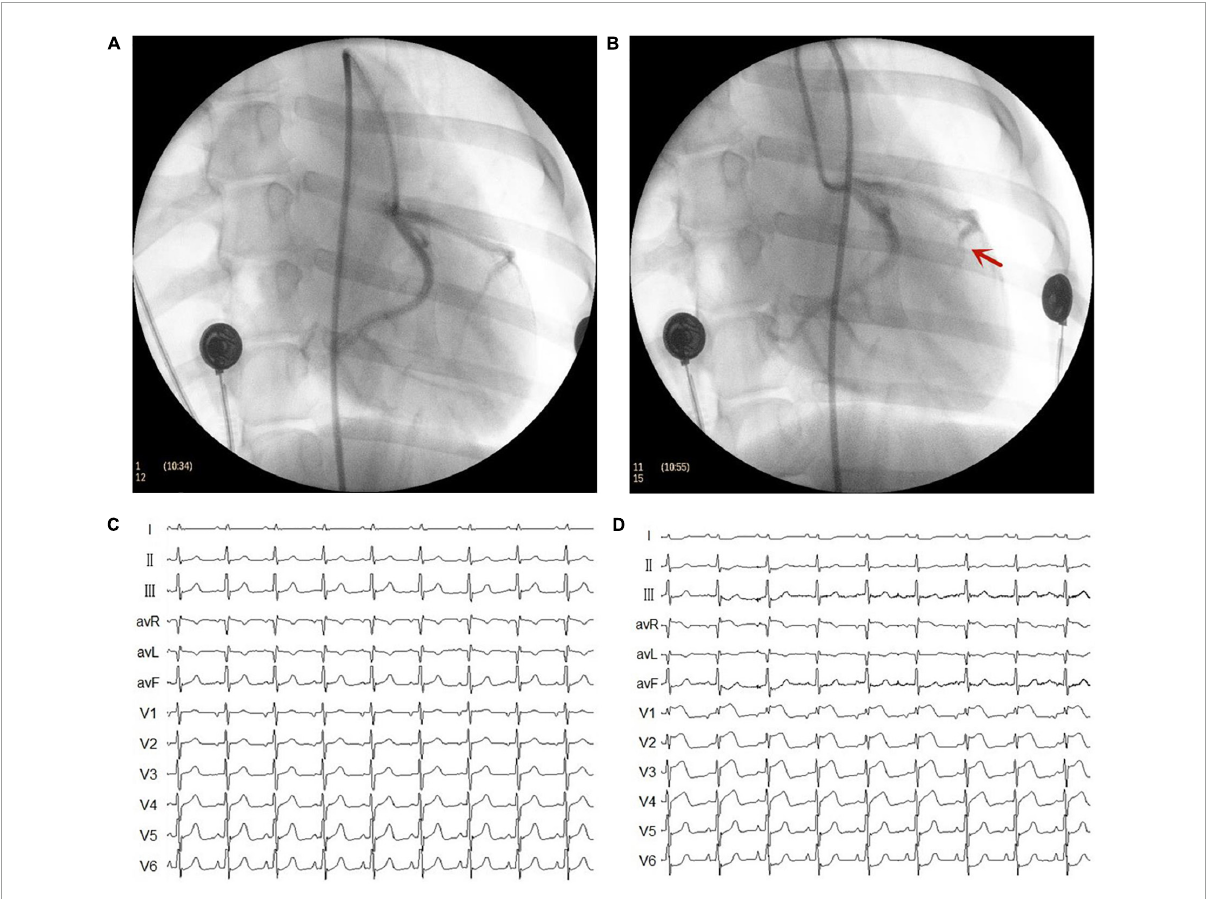
FIGURE1 Representative images of X-ray and electrocardiogram (ECG) changes during the myocardial infarction (MI) model. (A) Left coronary artery arteriography before gelatin sponge injection. (B) Left coronary artery arteriography after gelatin sponge injection. Notably, the distal anterior descending artery had obvious stenosis. (C) ECG before gelatin sponge injection. (D) ECG after gelatin sponge injection, the chest lead ST segment was elevated.